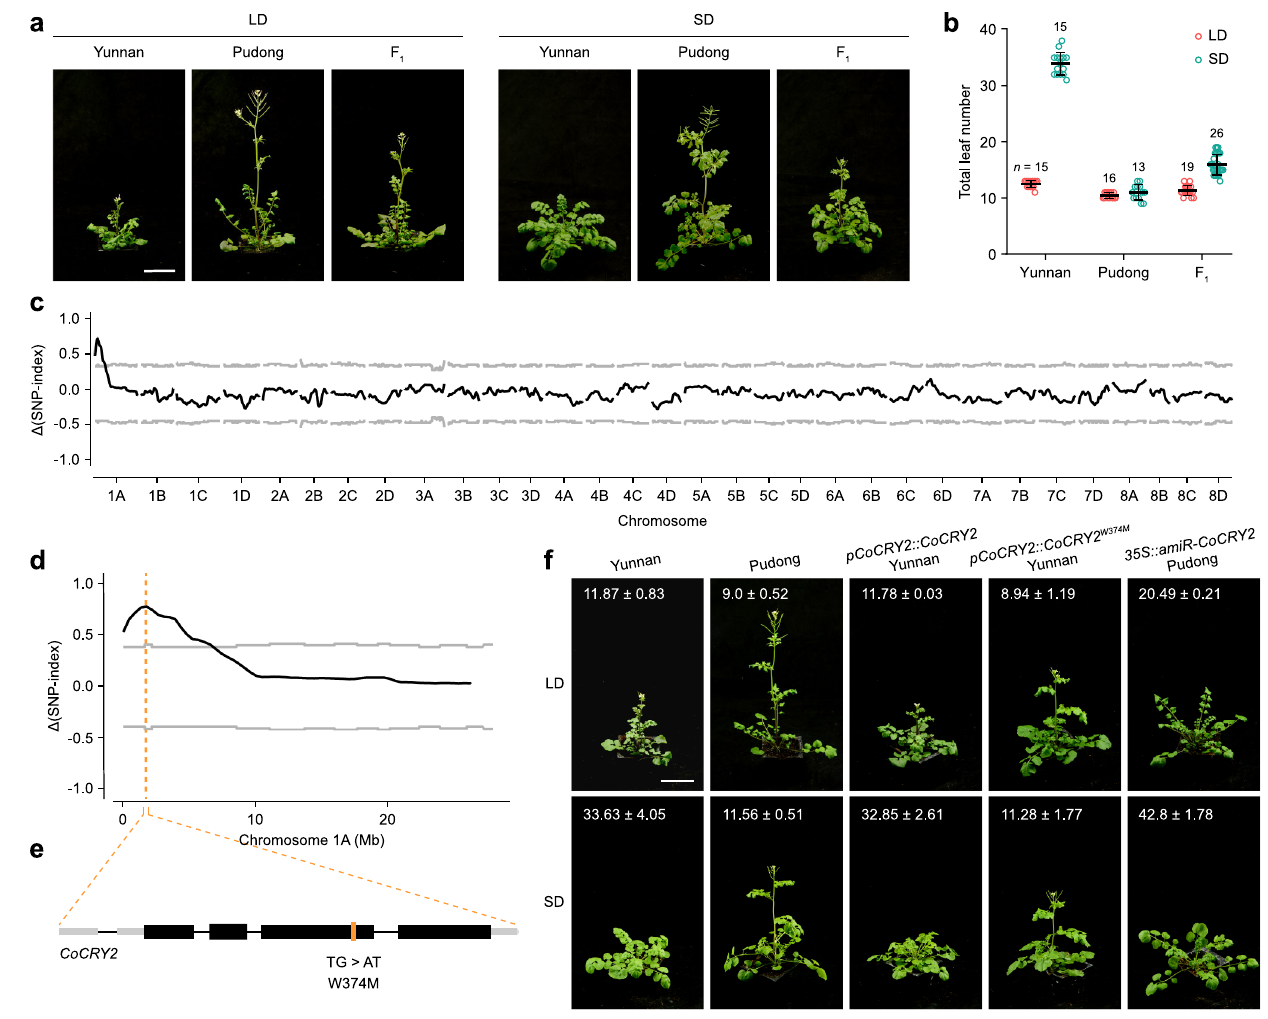
Fig. 4 | Identi fi cation of CRY2 as the gene responsible for early- fl owering in shortdays.a , b Floweringphenotypes( a )and fl oweringtime( b )oftheYunnanand Pudong accessions and Yunnan × Pudong F 1 plants grown under LD or SD condi- tions in a growth chamber. Error bars denote s.d. The number of examined plants ( n ) is given. The centers of the error bars represent the mean values. c Genome- wide Δ (SNP index) plot from BSA of the F 2 segregating population derived from a cross between Pudong and Yunnan. The black lines indicate tricube-smoothed Δ (SNP index),and the gray lines indicate correspondingtwo-sided99% con fi dence intervals. d Δ (SNP index)plot of Chr 1A from BSAof the F 2 segregatingpopulation derivedfromacrossbetweenPudongandYunnan.Theblacklineindicatestricube-